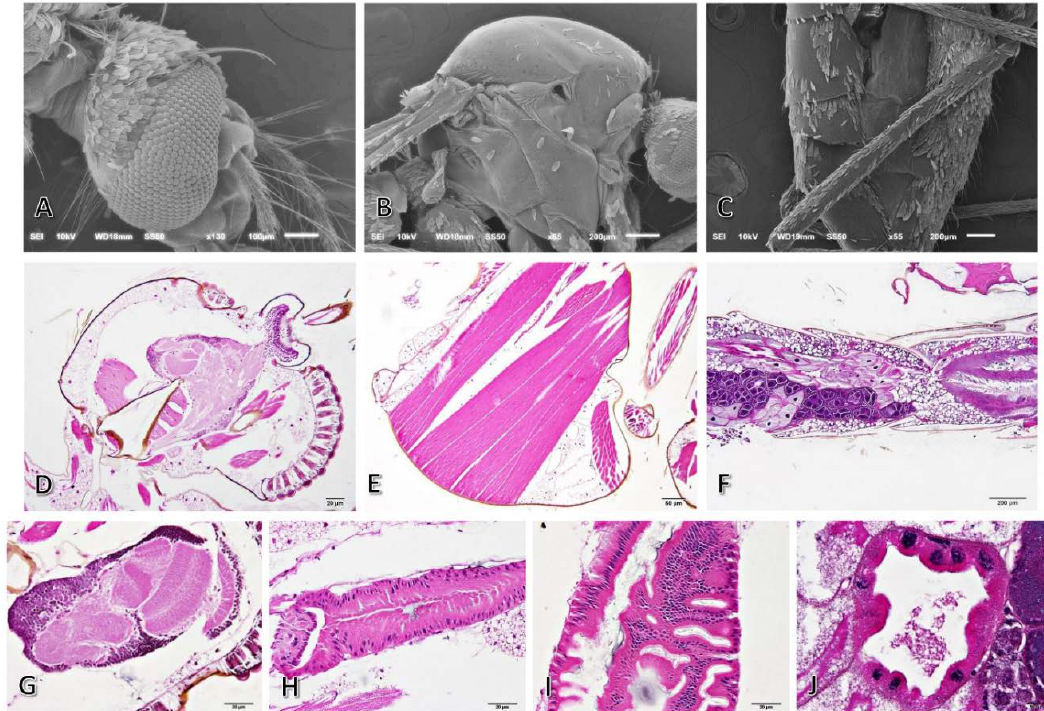
Figure 3. Ultrastructure and histology of mosquitoes with or without six types of essential oil treatment. No major external structural alternations were observed in mosquitoes treated with essential oils compared to untreated mosquitoes. Fine structure of head ( A ), thorax ( B ) and abdomen ( C ) in the mosquitoes subjected to oil extract treatment indicating intact external architecture with general loss of scales Histopathological micrograph of non-treated mosquitoes from head ( D ), thorax ( E ) and abdomen ( F ), which represented the intact compound eyes ( D and G ), oesophageal ganglion ( G ), head and thoracic muscle ( D , E ) and intestinal tract; anterior, middle and hind gut ( H , I and J , respectively).